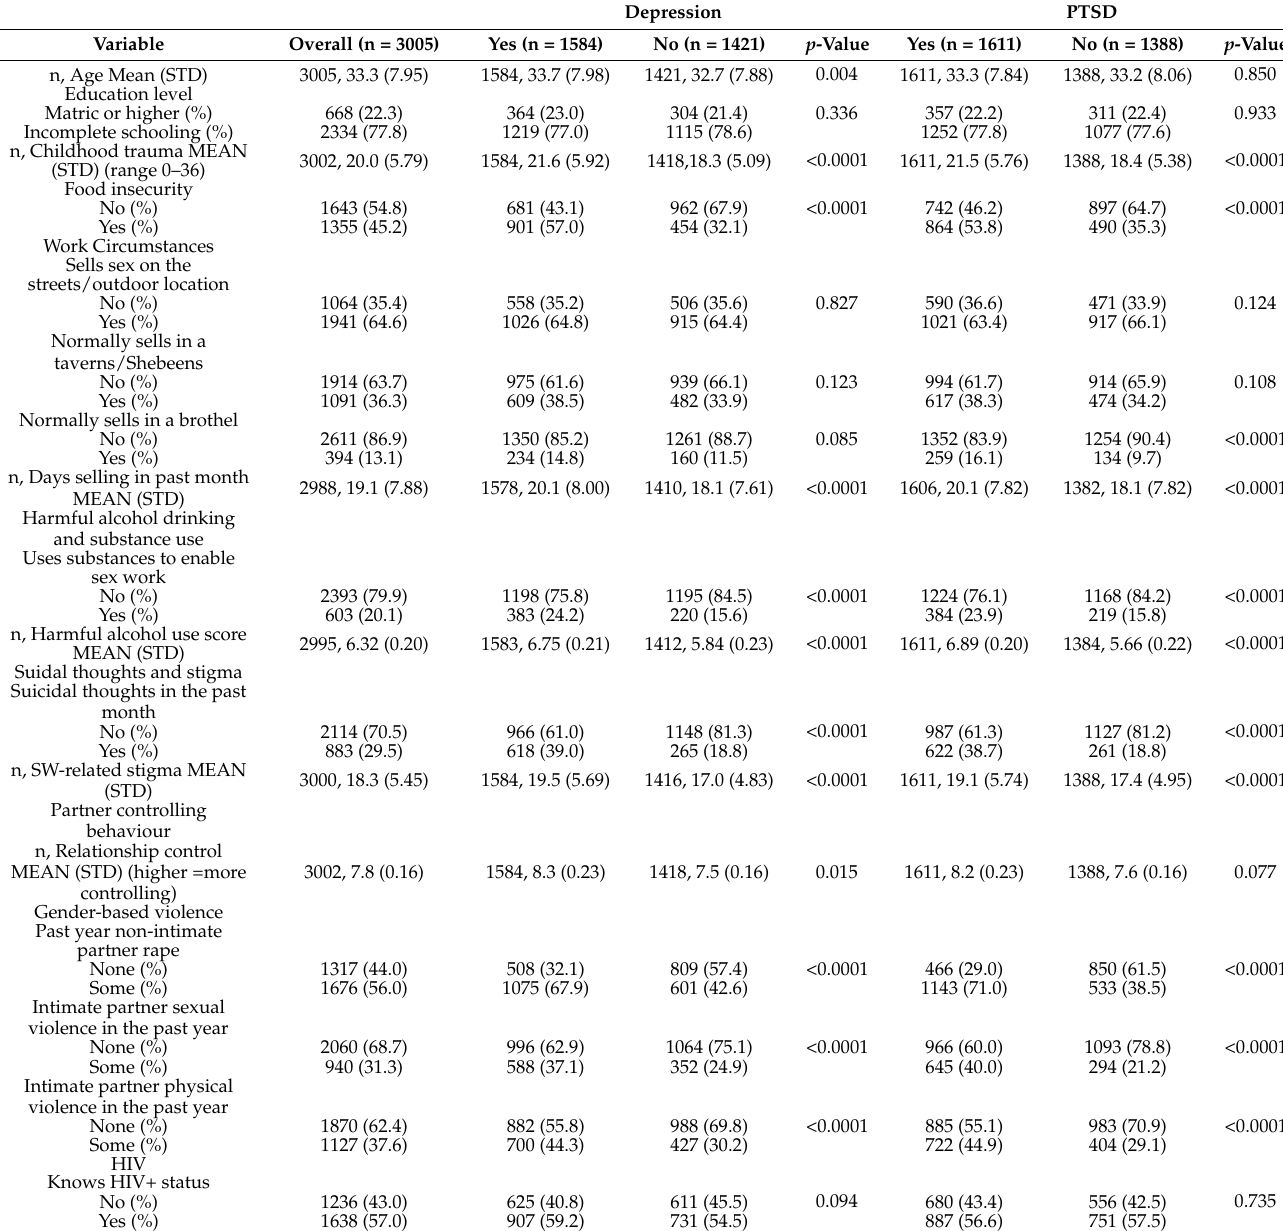
Table 2. Characteristics of participants by mental